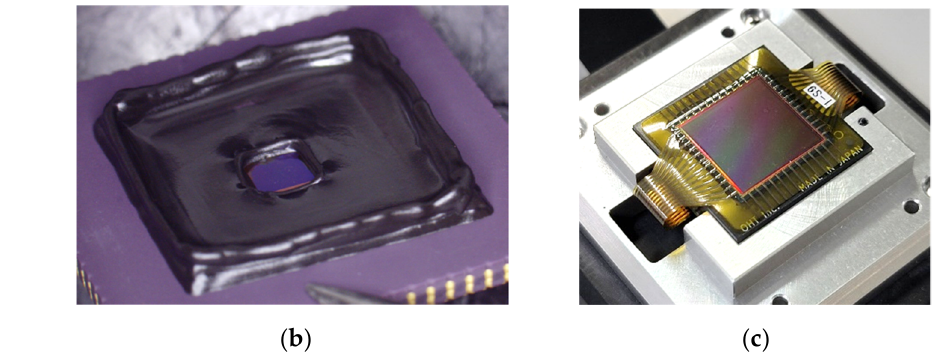
Figure 8. Various assembly methods of the sensor chips: ( a ) ceramic package with bonding wires; ( b ) resin potting; ( c ) polyimide film with flexible wires.